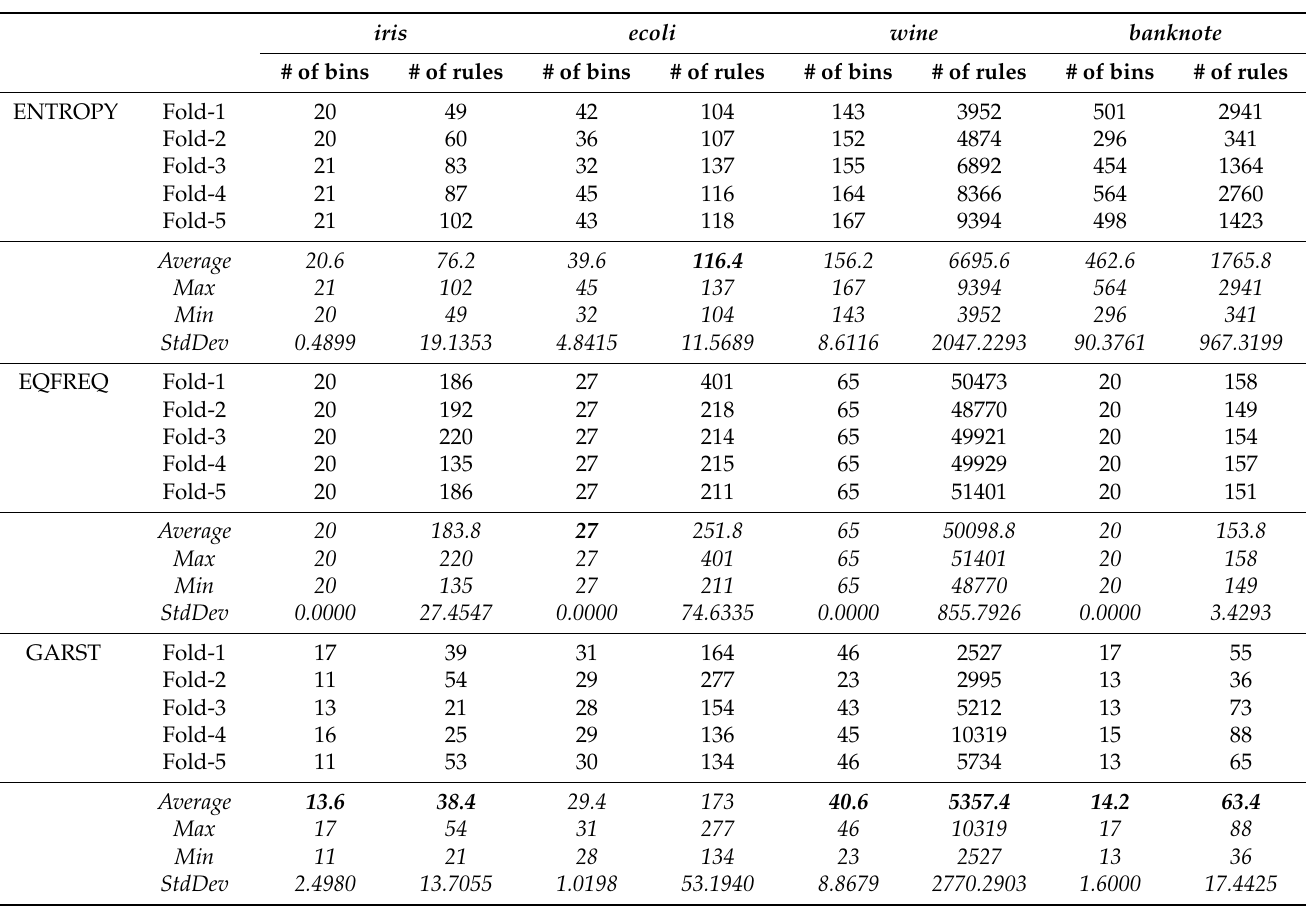
Table 3. Number of bins and rules generated by each